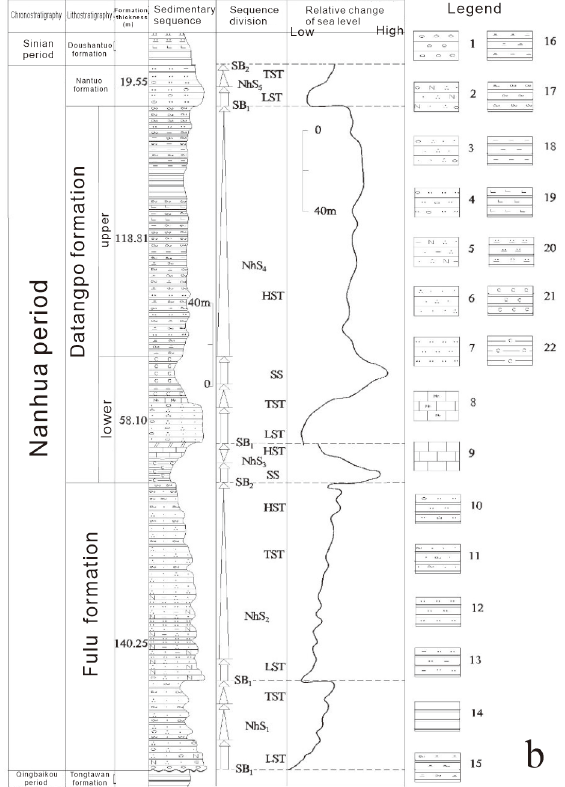
Figure 2. ( a ) The lithofacies paleogeography map of Songtao-Huayuan in the Nanhua period and Datangpo period. ( b ) The sequence stratigraphic division map of the Nanhua period (provided by the Hunan Geological Survey Institute).